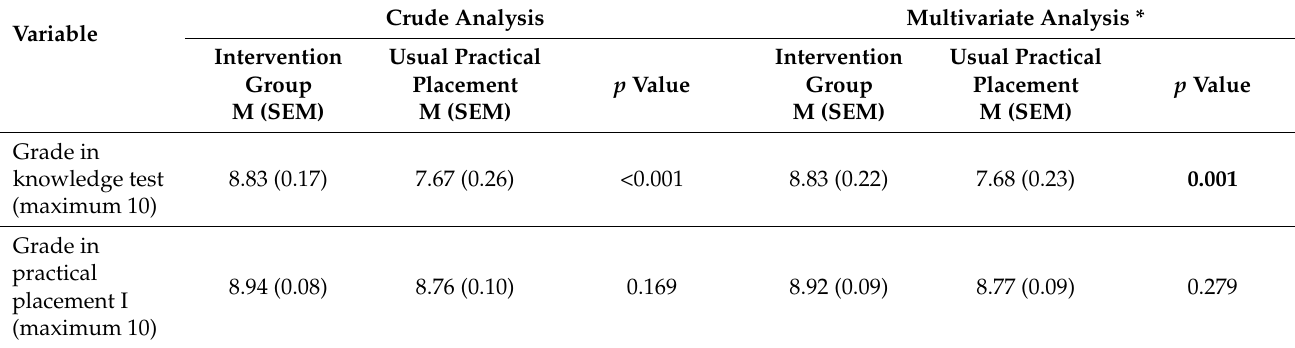
Table 3. Effect of the intervention (teaching ward round) in the acquisition of knowledge and practical clinical